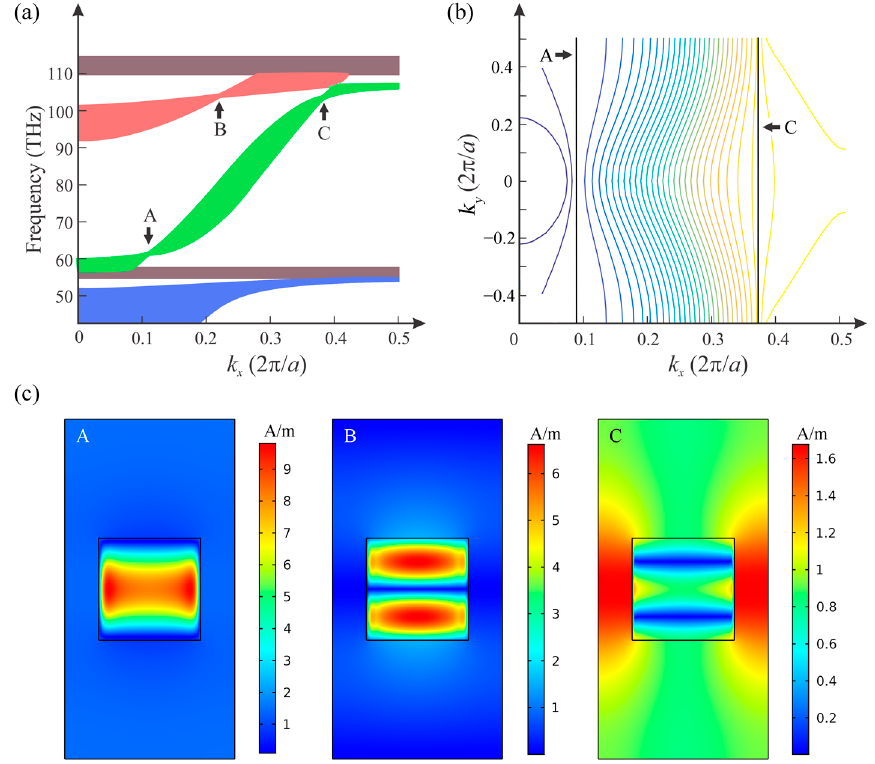
Figure 3. ( a ) Band structure of the 2D PHC in infrared region. Points A (59.52 THz), B (102.90 THz) and C (102.60 THz) are where dispersion curves collected, located in the third (green) and fourth (red) bands. ( b ) Equifrequency contours of the third band. ( c ) Magnetic field (|H|) Profiles of points A, B and C in a unit cell of the PC.